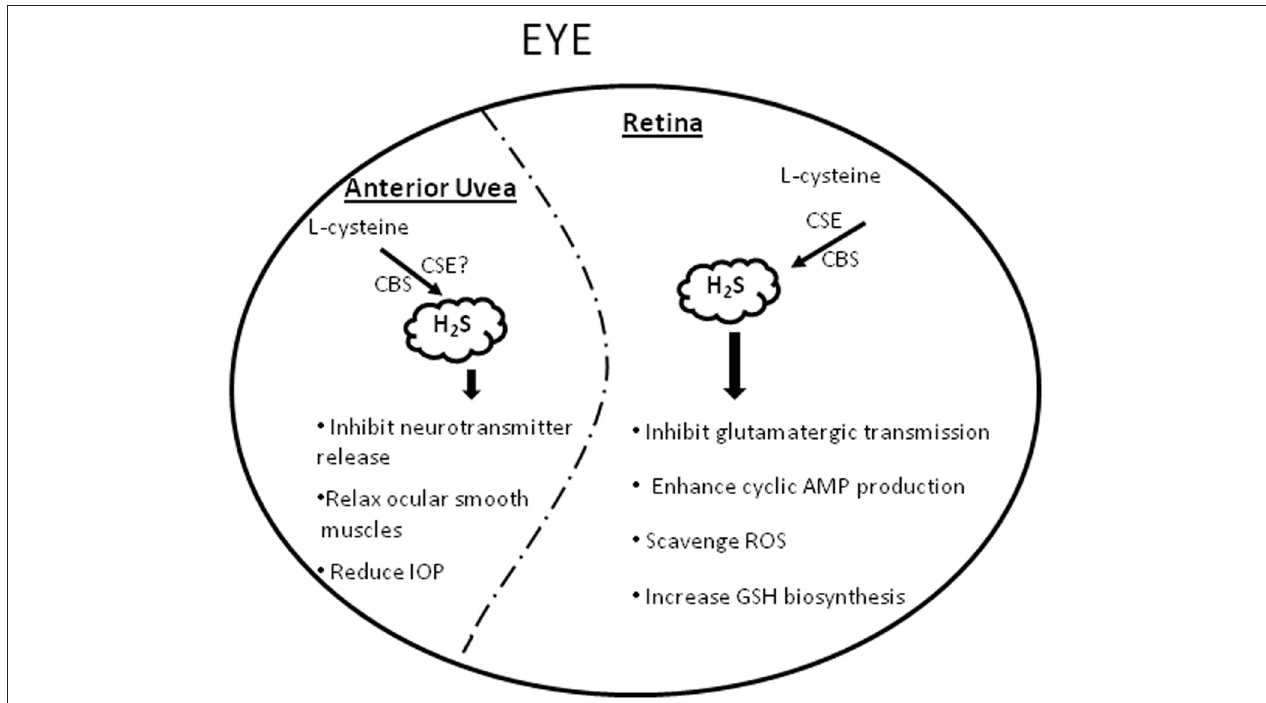
FIGURE 1 | A schematic representation summarizing the physiological and pharmacological effects of H 2 S in the eye. GSH = glutathione, ROS = Reactive oxygen species, IOP = intraocular